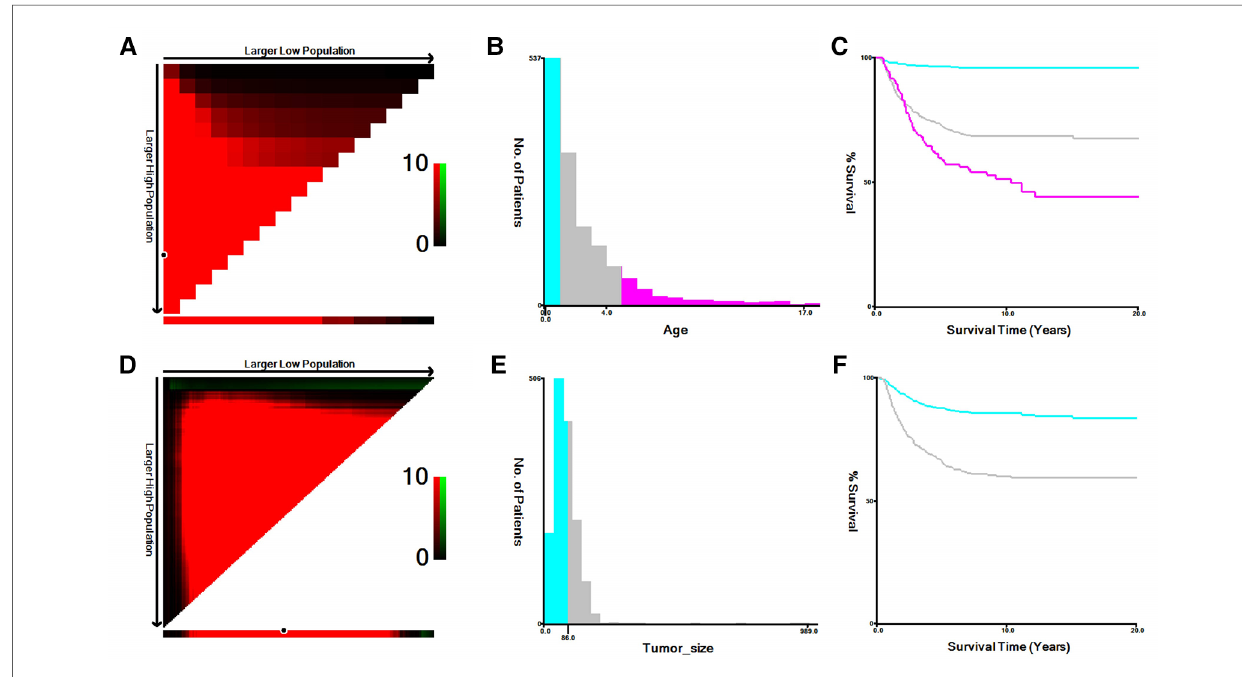
FIGURE 2 The optimal cutoff values of age and tumor size identi fi ed by X-tile. ( A,B ) The optimal cutoff value of age. ( C ) The Kaplan – Meier curves for the subgroups of age (<1, 1 – 5, ≥ 5) for CSS. ( D,E ) The cutoff value of tumor size. ( F ) The Kaplan – Meier curves for the subgroups of tumor size (<8.7 cm, ≥ 8.7 cm) for